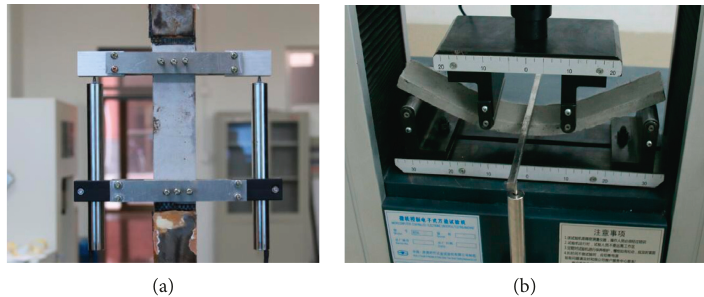
Figure 2: Test setups for direct tensile and four-point bending tests of ECC. (a) Uniaxial tensile test. (b) Four-point bending test.